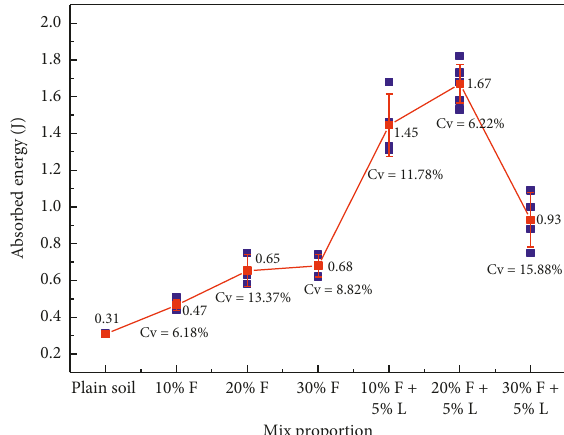
Figure 7: Absorbed energy curve of soil under different mix